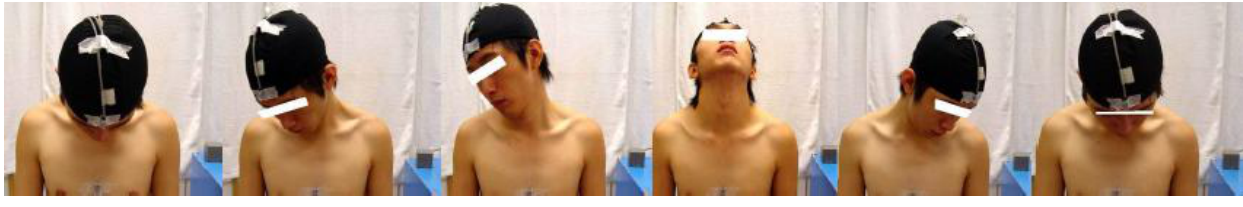
Figure 2. Measurement method for measuring the motion of cervical circumduction: the motion of cervical circumduction was a consecutive combination of flexion, extension, lateral flexion, and slight